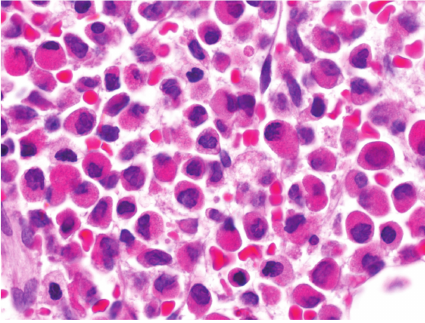
Figure 1: Promyelocyte in the peripheral blood smear.